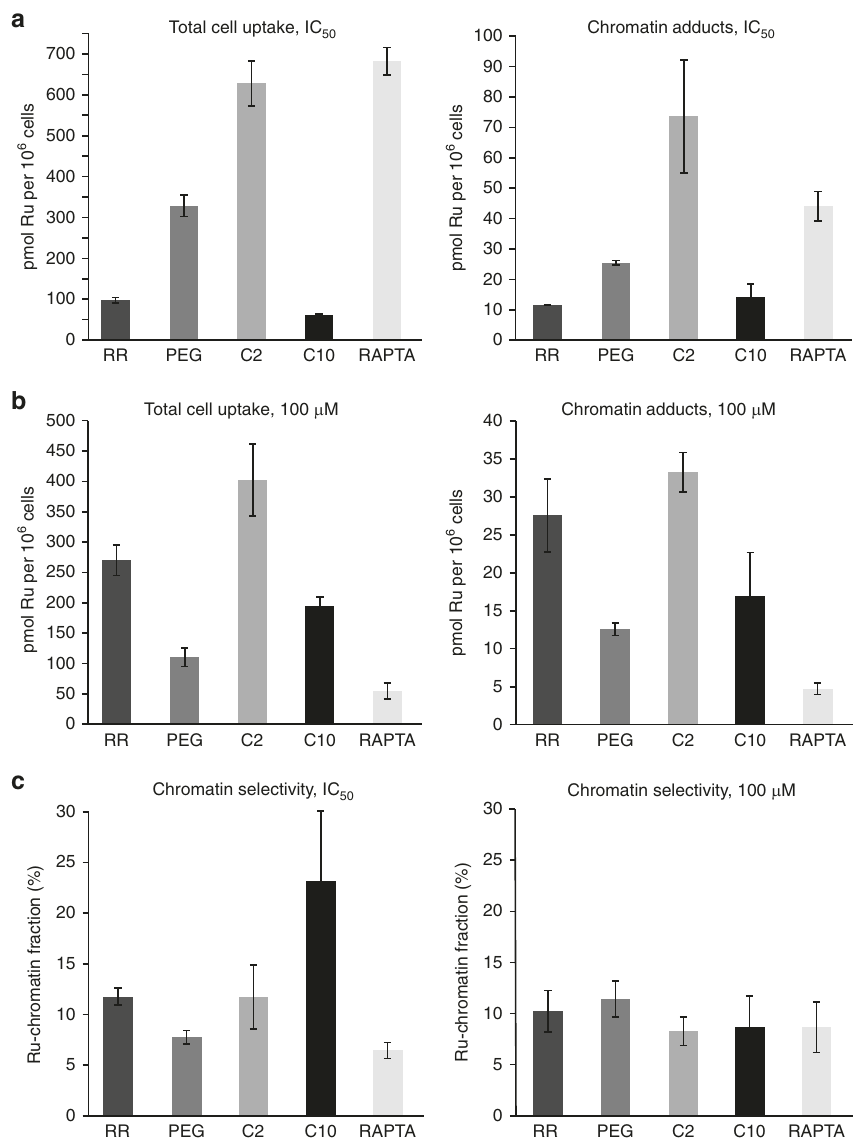
Fig. 3 Quanti fi cation of cellular uptake and chromatin binding of binuclears and mononuclear RAPTA drug. a , b Cells were treated with binuclear agent or RAPTA-C (RAPTA) either at concentrations corresponding to their respective IC 50 values (Fig. 1; mean ± s.d., n = 3; a ) or at an equimolar concentration of 100 μ M ( b ; mean ± s.d., n = 3). Ruthenium levels were determined by inductively coupled plasma-mass spectrometry. c Chromatin selectivity is expressed as the fraction of the total agent taken up by the cell that is chromatin-associated (chromatin adducts/total cell uptake) for either the IC 50 (left) or 100 μ M (right) treatments (mean ± s.d., n =